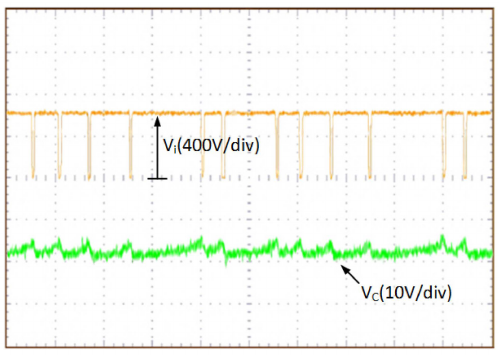
Figure 16. Amplified waveforms of the input voltage of the inverter bridge and the Z-source capacitor voltage corresponding to Figure 15.